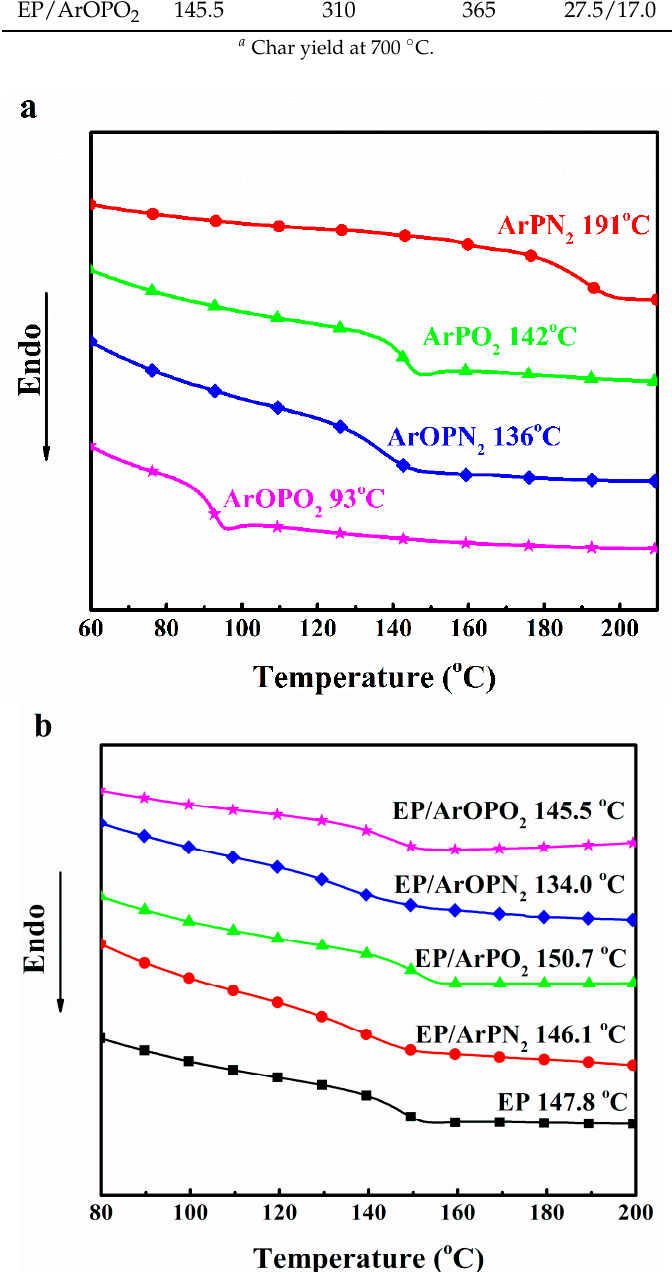
Figure 2. Differential scanning calorimetry (DSC) curves of polysulfone ( a ) as well as EP and EP/polysulfone composites ( b ).